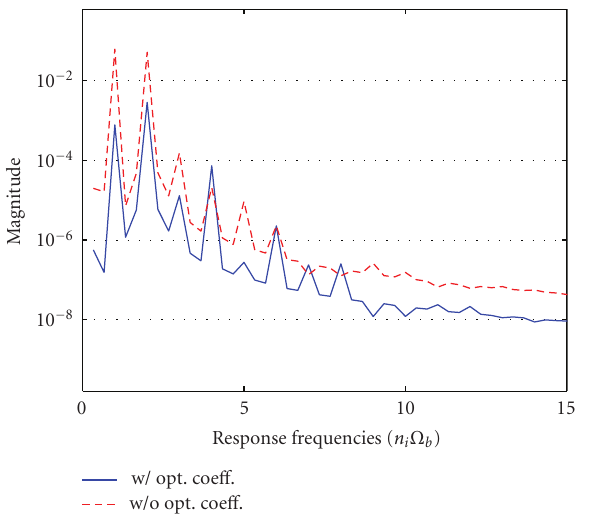
Figure 15: Horiz. response mag. profiles at Ω b = 1 . 5, bearing 2.